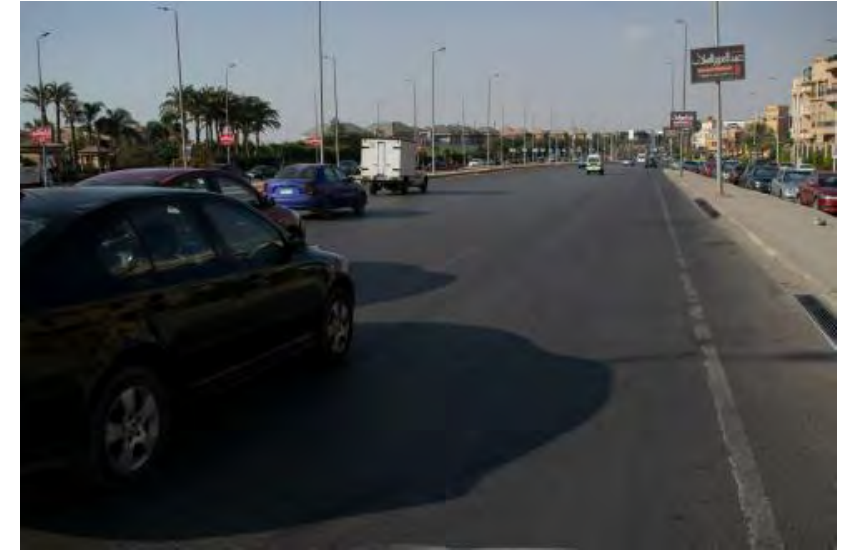
Fig. 30: After side drainage. (Source: the authors)